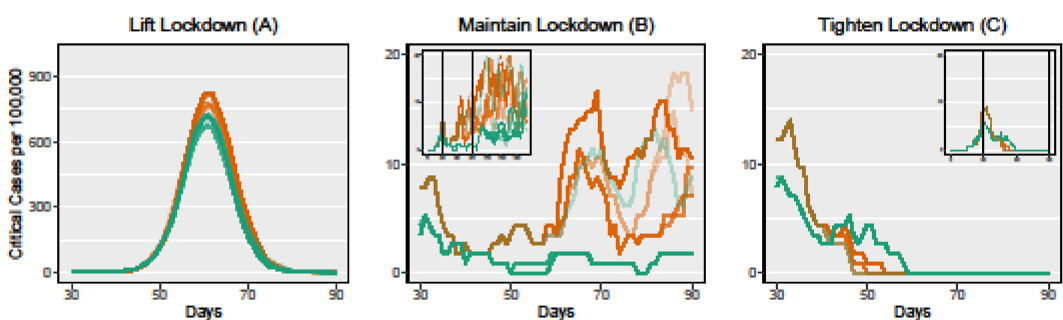
Figure 3. Varying TB rates. Each panel depicts 10 simulated courses of COVID-19 measured in critical cases per 100,000 inhabitants with a TB rate varying from 0% (green line) to 1% (red line). The small panels depict the course over a longer time horizon (200